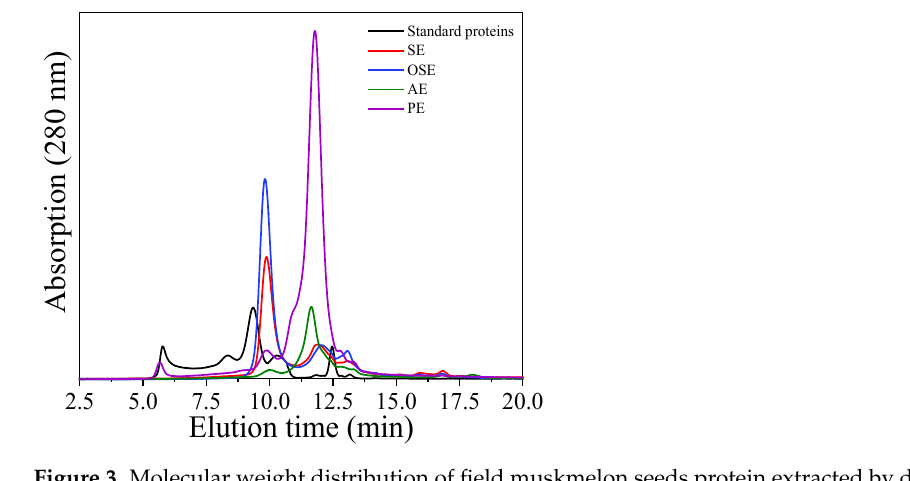
Figure 3. Molecular weight distribution of field muskmelon seeds protein extracted by different oil extraction methods.